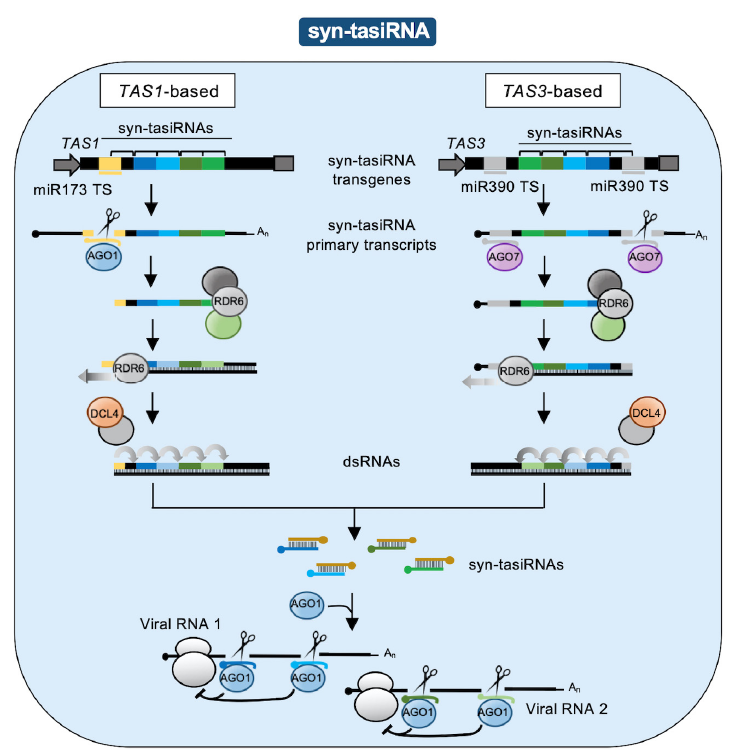
Figure 2. TAS -based antiviral syn-tasiRNA pathways in plants. Left, TAS1 -based syn-tasiRNA pathway. Right, TAS3 -based syn-tasiRNA pathway. Other details are as in Figure